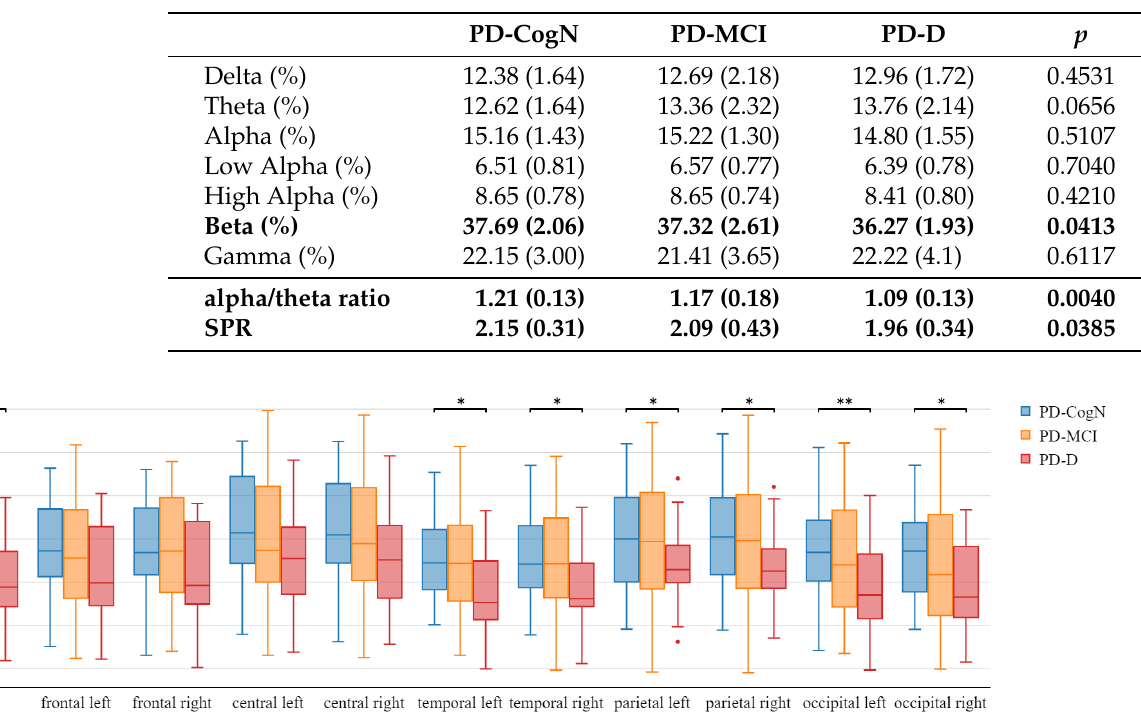
Table 3. Mean (standard deviation) global relative power in subgroups. Bold indicates statistically significant differences.